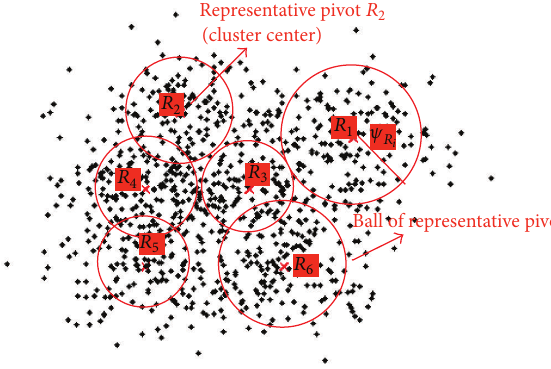
Figure 2: Basic structure of PSB ( R 1 , R 2 , R 3 , R 4 , R 5 , R 6 are representative